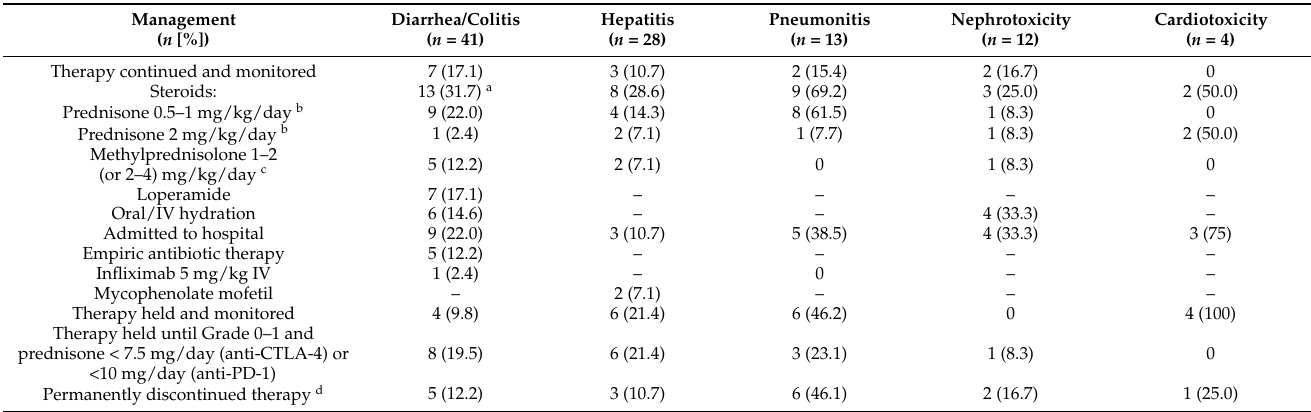
Table 5. Aggregated data for the management of immune-related adverse events in Nova Scotia Health-Central Zone patients treated with nivolumab plus ipilimumab, nivolumab, or ipilimumab, categorized by organ system.